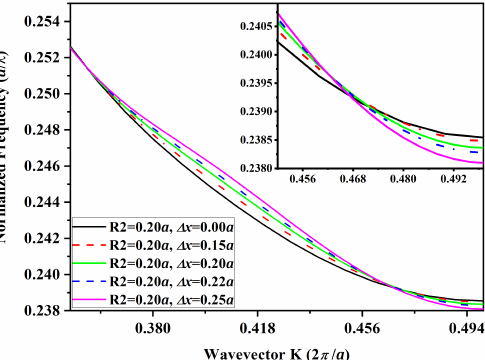
Figure 4. Dispersion profiles corresponding to R2 = 0.20 a , while ∆ x is variable, the inset shows partially zoomed-in lines.